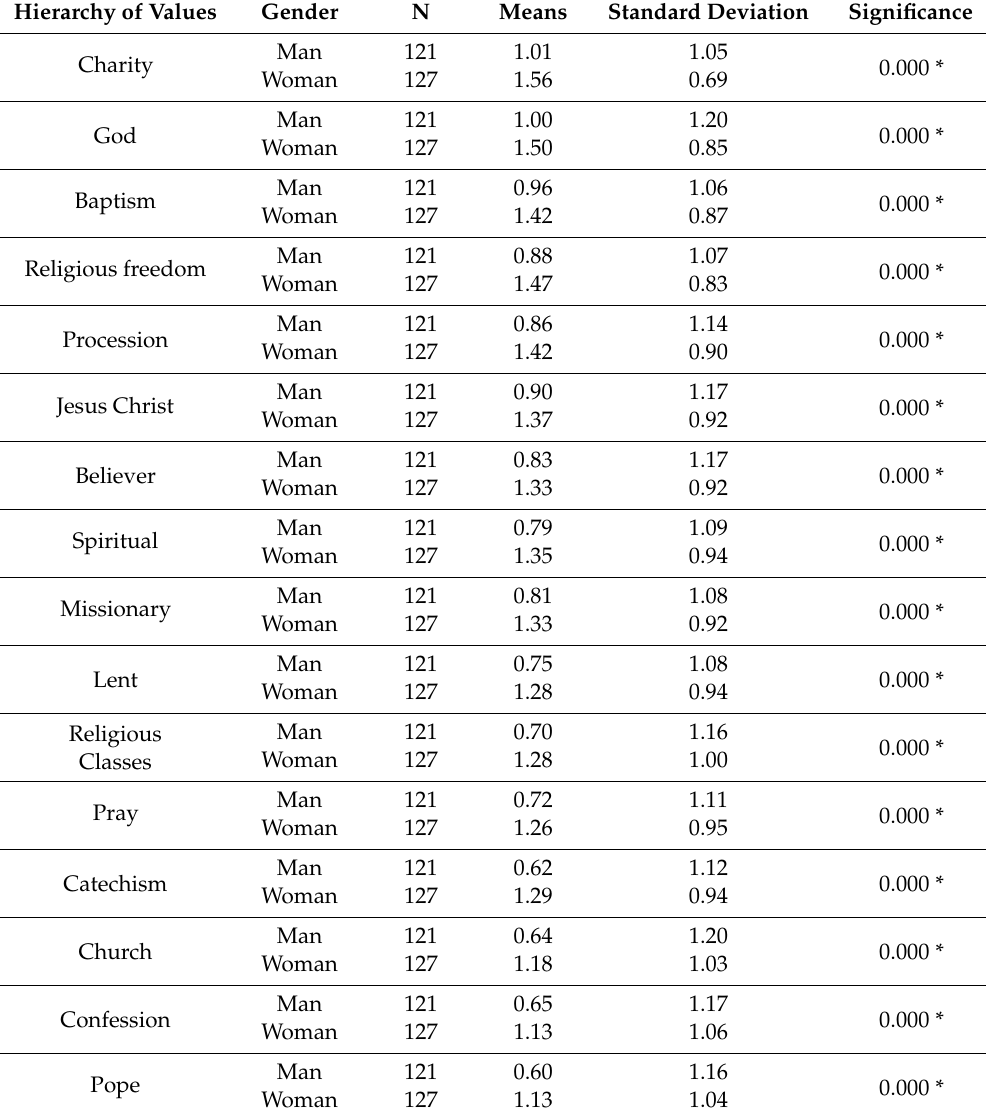
Table 8. One-way analysis of variance according to the variable gender of the students. Hierarchy of Values Gender N Means Standard Deviation Significance